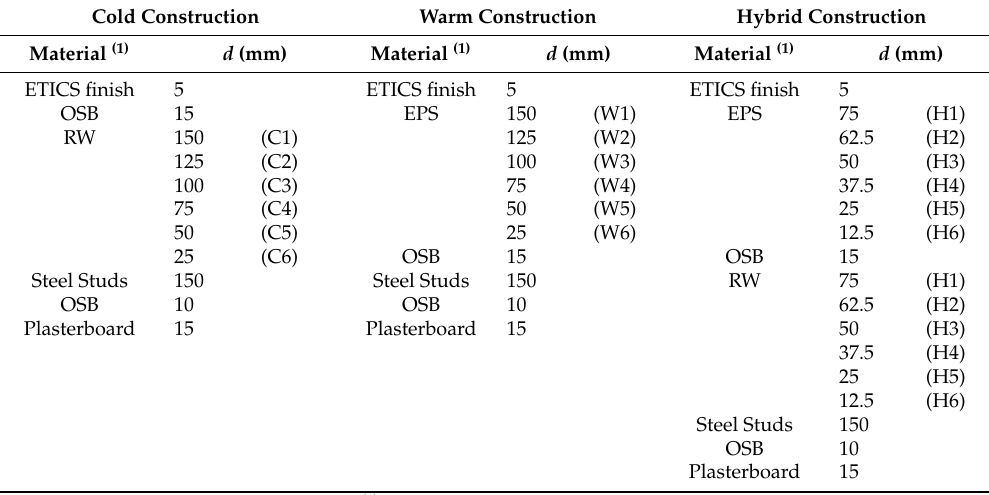
Table 3. Evaluated LSF walls and model references between